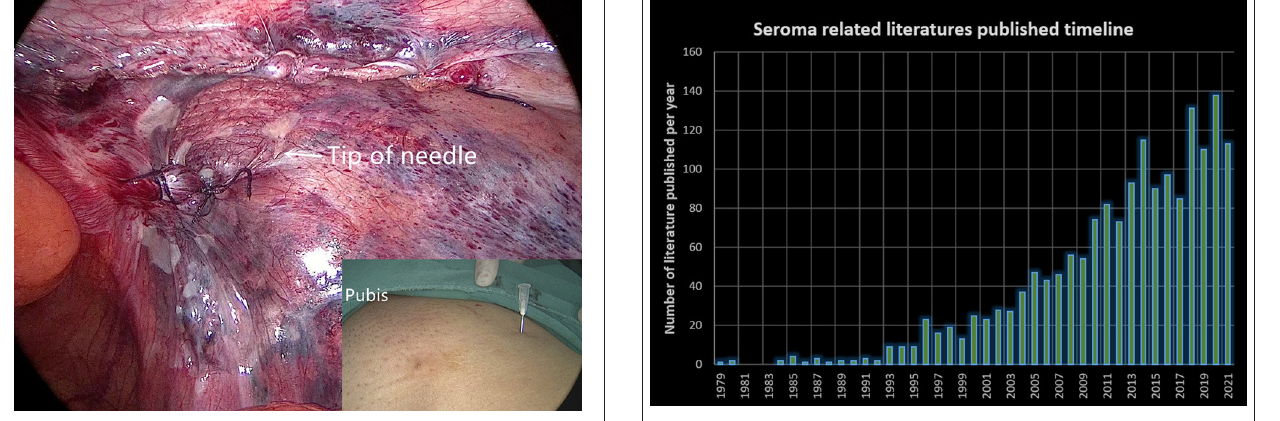
FIGURE 7 | The peritoneum and mesh are pressed against the abdominal wall after thick needle deflation.